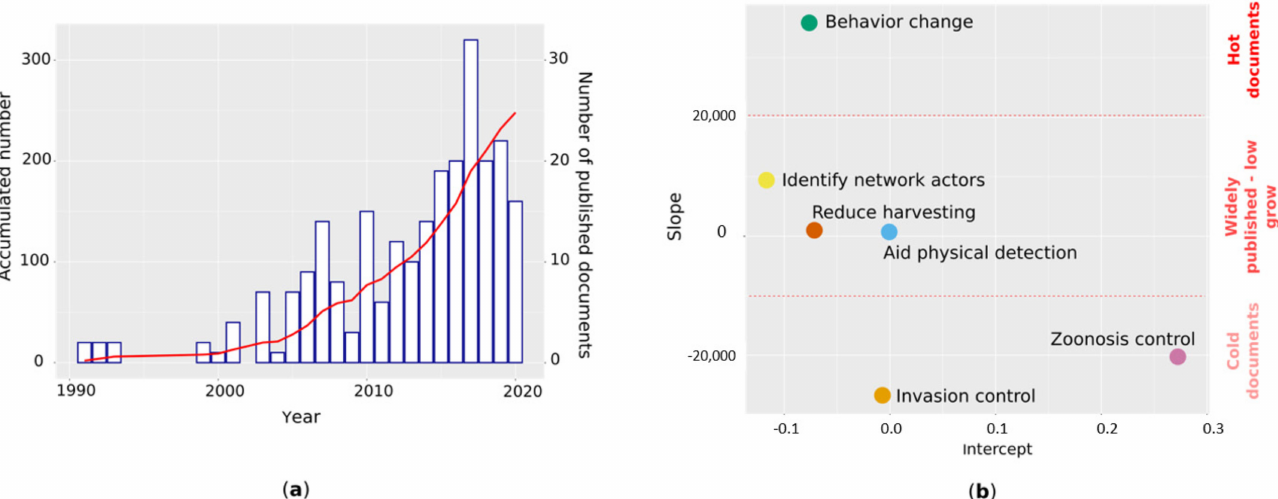
Figure 1. Temporal pattern in the published illegal parrot trade literature. ( a ) Published production across the years. The number of published documents by year (blue bars) and the accumulated number (red line) are shown. ( b ) Temporal pattern in action aims reported in the published literature. Hot, medium, and cold documents represent coarse groupings defined for example purposes only, and should not be considered as statistically robust.